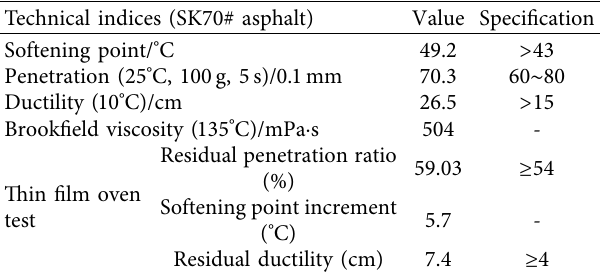
Table 1: Technical properties of 70#